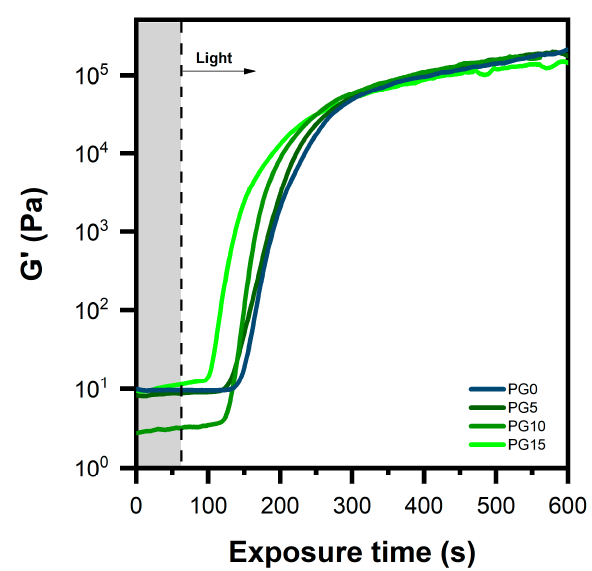
Figure 2. Photopolymerization kinetics of the different formulations (light switched on after 60 ′′ ).